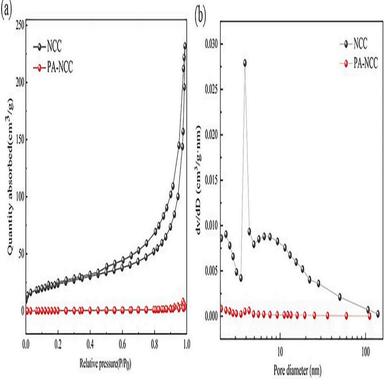
Analysis of the adsorption and desorption performance of porous support materials.